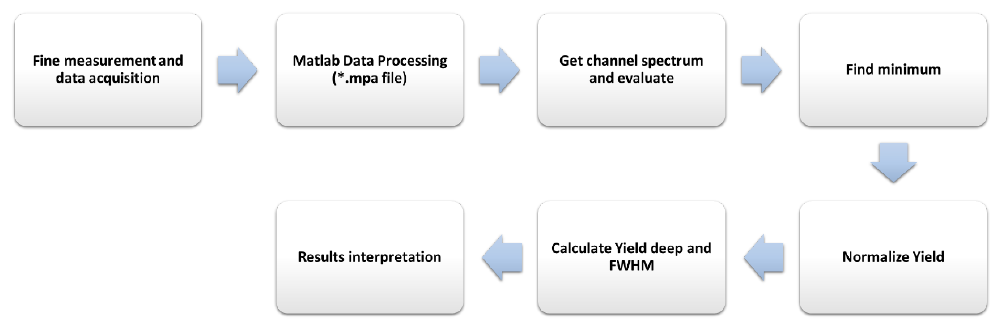
Figure 8. Fine RBS/C methodology.